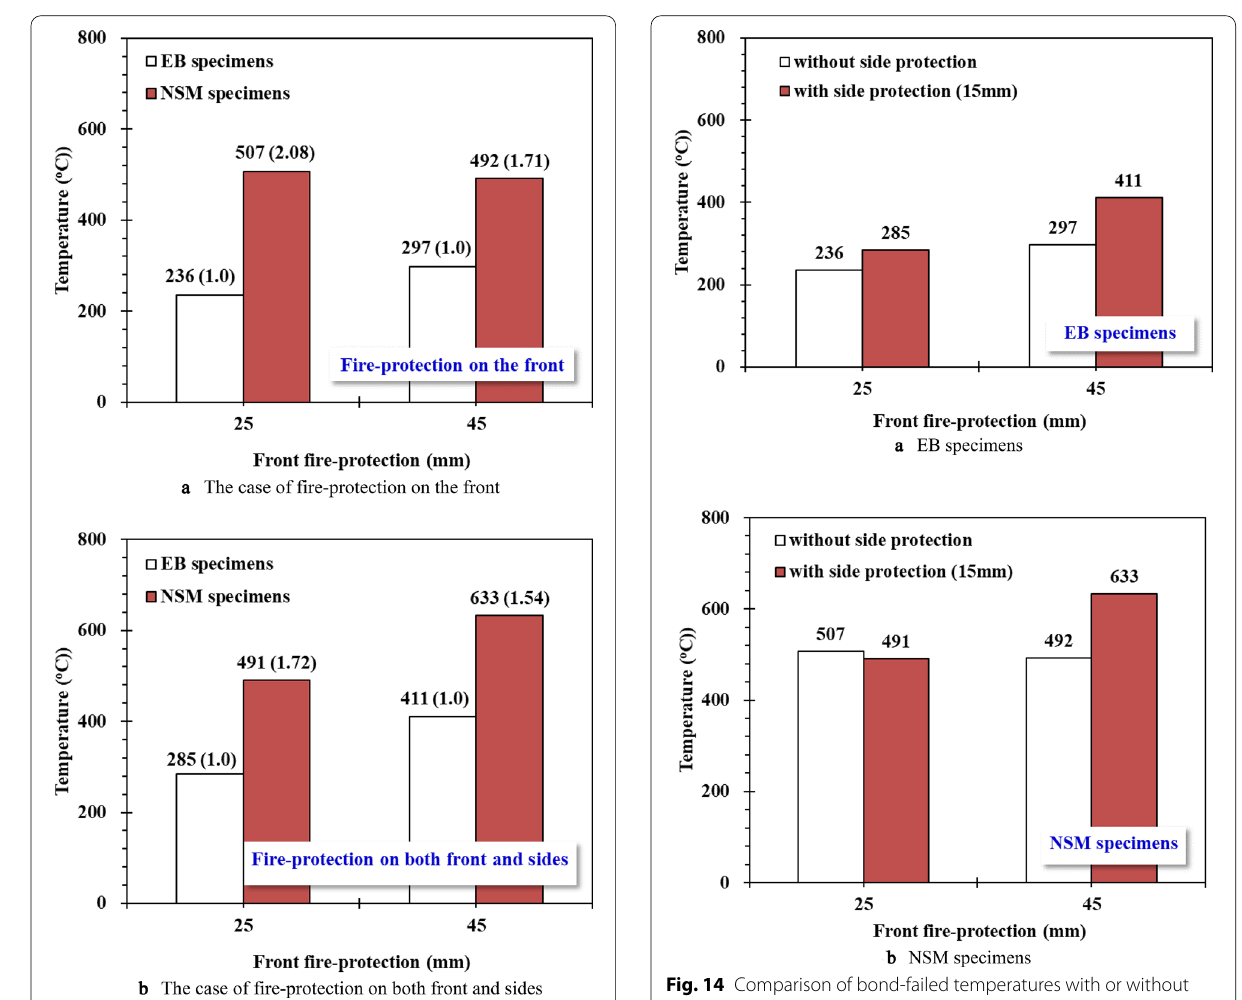
Fig. 13 Comparison of bond‑failed temperatures between EB and NSM specimens.